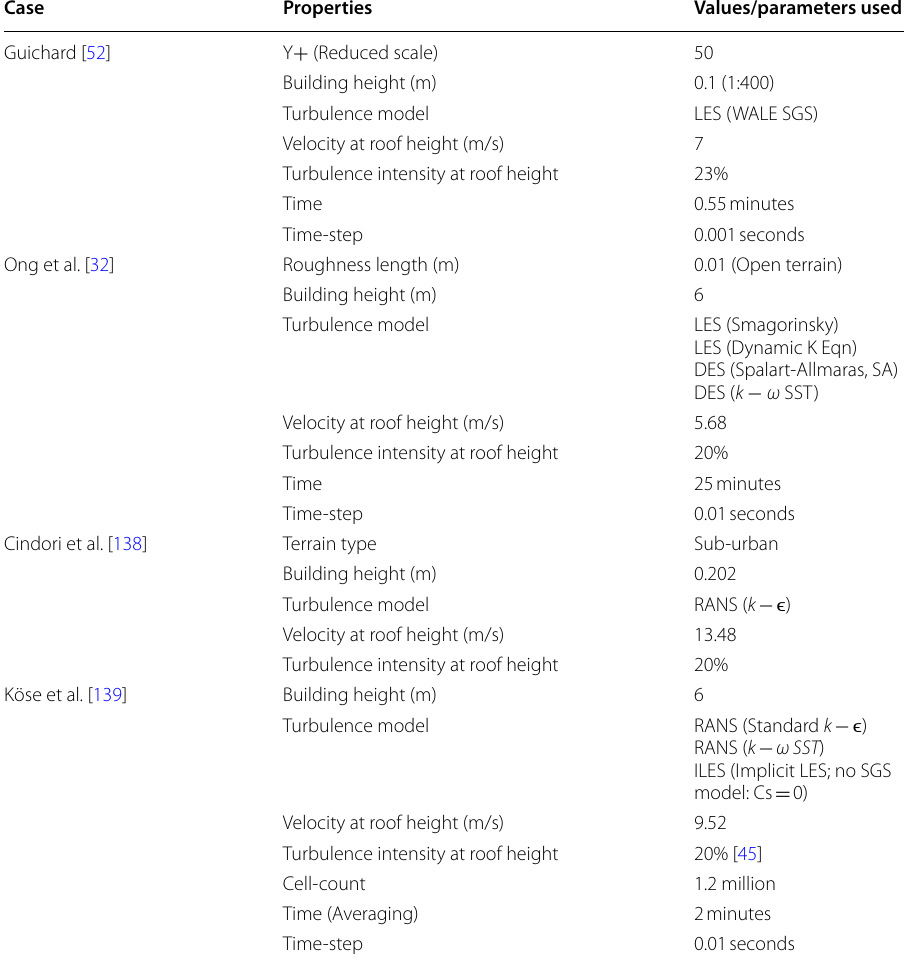
Table 4 Available information on different simulations